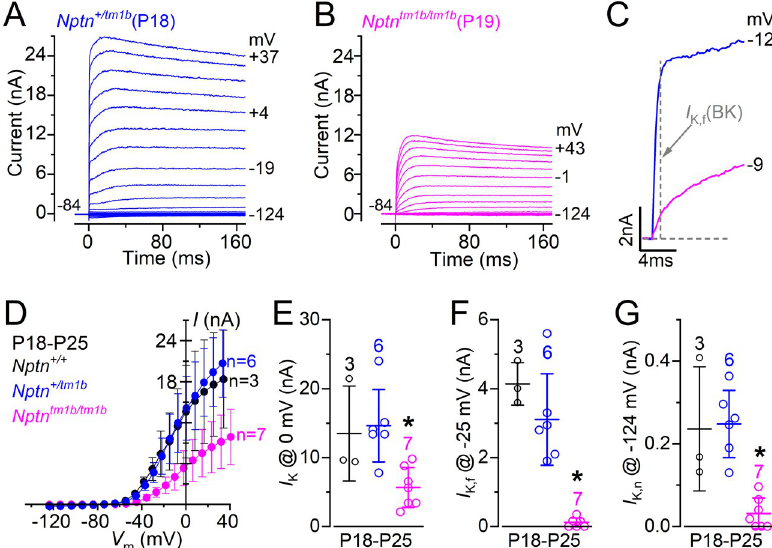
Fig 5. Neuroplastin is required for normal IHC maturation. (A, B) Current responses from IHCs of heterozygous (A: Nptn +/tm1b , P18) and homozygous (B: Nptn tm1b/tm1b , P19) mice, which is after hearing onset at P12. Current recordings were elicited by using depolarising and hyperpolarising voltage steps (10 mV increments) from the holding potential of –84 mV to the various test potentials shown by some of the traces. (C) An expanded version of the first 10 ms of the current traces from panels A and B, which emphasises the presence of the rapidly activating I K,f . (D) Steady- state current-voltage curves obtained from P18-P25 IHCs from the three genotypes. (E-G) Size of the total outward K + current I K (E), the isolated I K,f (F) and I K,n (G). The size of I K,f was measured at –25 mV and 1 ms from the onset of the voltage step [24]. The size of I K,n was measured as the difference between the peak and steady-state of the deactivating inward current at –124 mV [21]. The number of IHCs recorded are shown above each column. Average data are plotted as mean ±